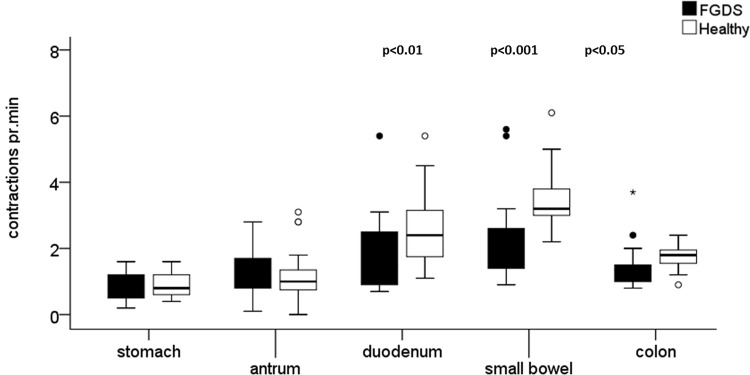
Number of contractions obtained by Wireless Motility capsule (WMC).Box plots showing number of contractions per min in stomach, antrum, duodenum, small bowel and colon recorded by WMC. There was no significant difference between the two groups in stomach or antrum. In the duodenum, small bowel and in colon there was significant differences between FGDS and HC. The median is shown within the box; the box represents the 25 and 75 percentiles and the whiskers 10 and 90 percentiles.